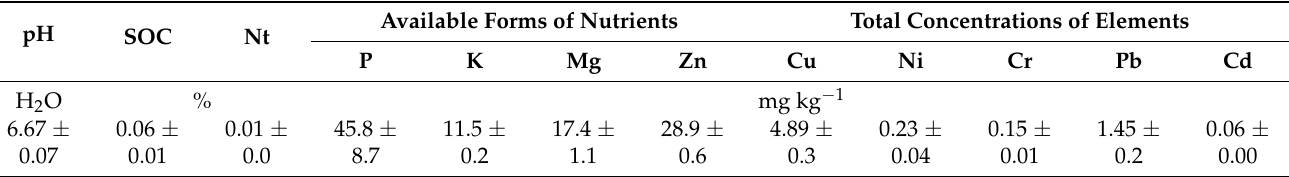
Table 1. Selected properties of soil used in the pot experiments (mean ±